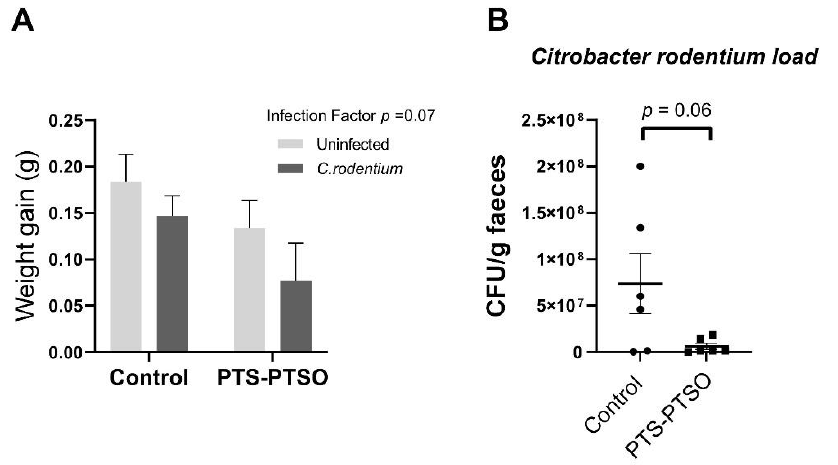
Figure 5. PTS-PTSO reduces C. rodentium faecal load. ( A ) Weight gain per day during infection phase in mice given control water, 1 mg/kg PTS-PTSO and 10 9 CFU C. rodentium . ( B ) Faecal load of C. rodentium in mice treated with or without PTS-PTSO. Data bars represent mean ± SEM. n = 6 per group.